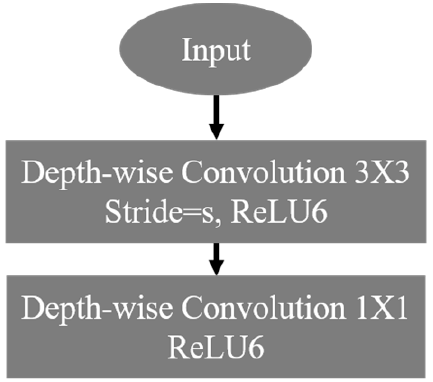
Figure 4. MobileNet architecture.